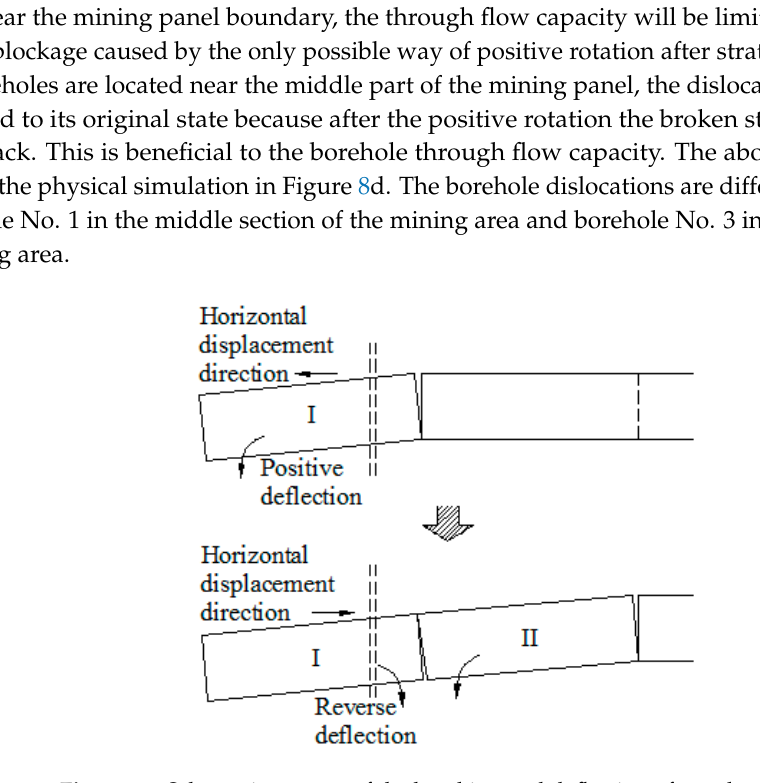
Figure 11. Schematic process of the breaking and deflection of a rock stratum.